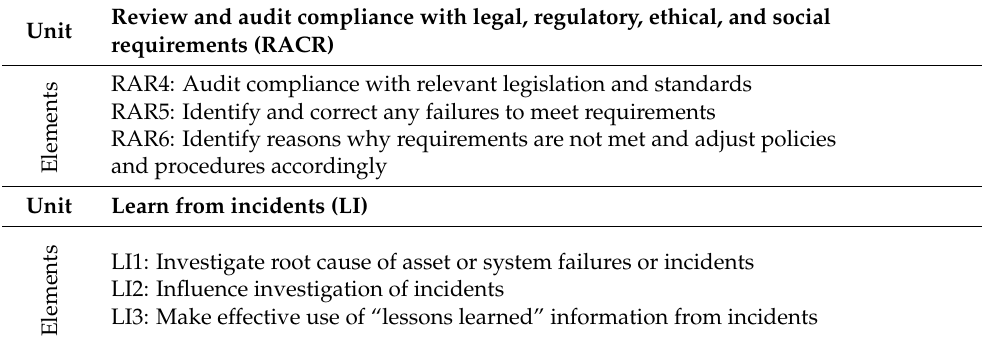
Table A2. Cont . Unit